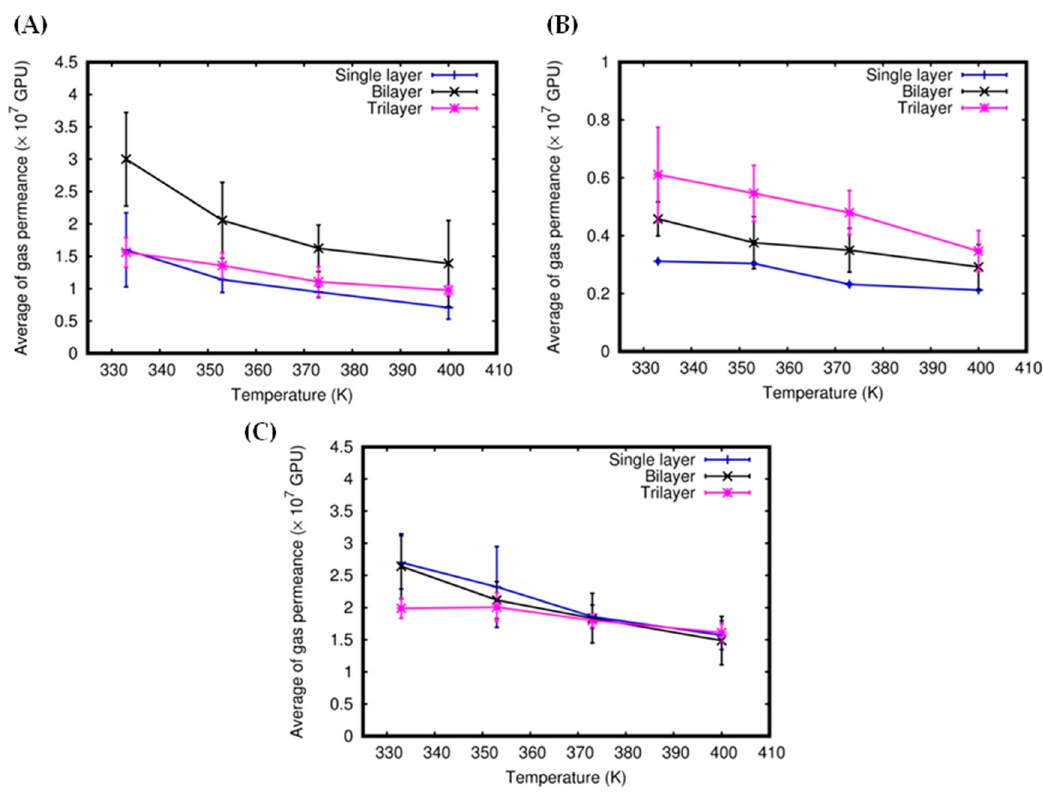
Figure 5. Average of gas permeance as a function of temperature: CO 2 ( A ), N 2 ( B ), and H 2 O ( C